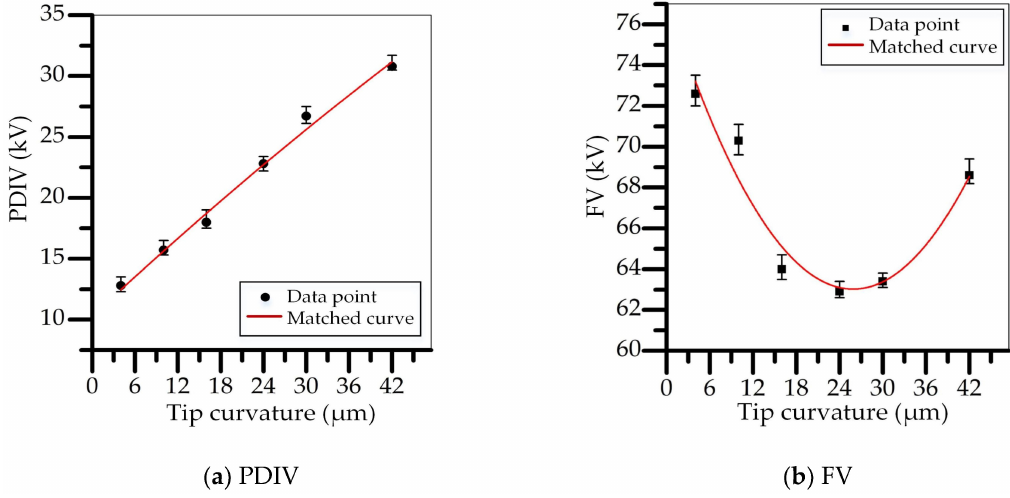
Figure 4. Characteristics of PDIVs and FVs before formal